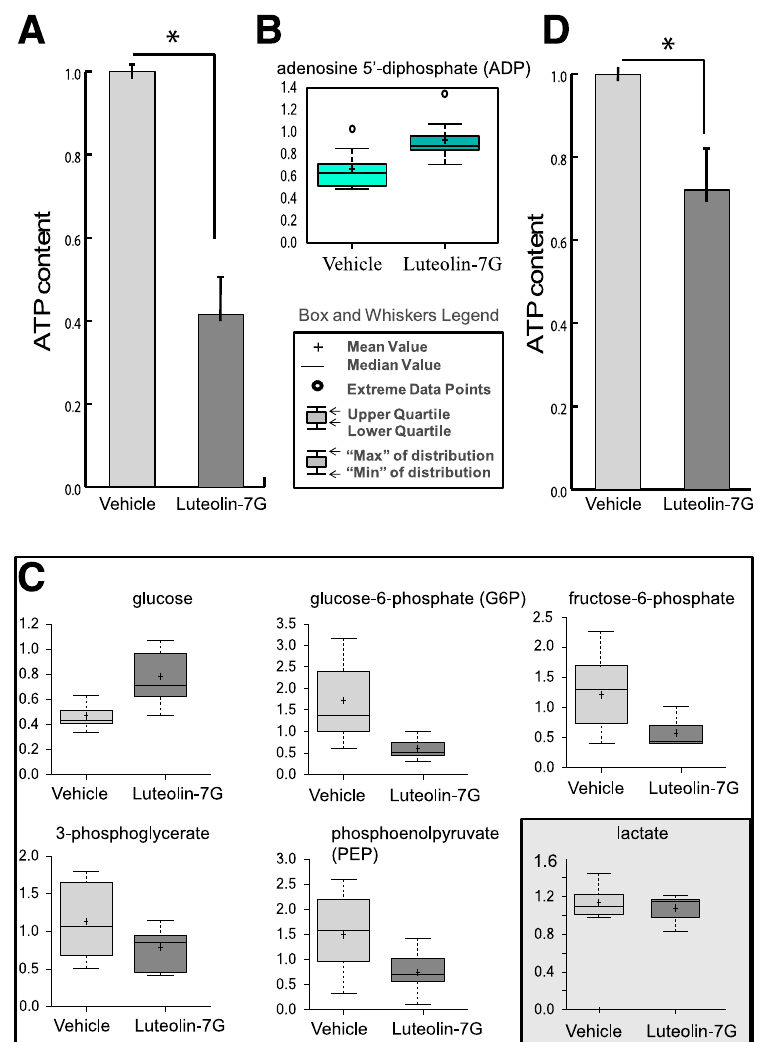
Figure 1. ( A ) Cellular ATP content in keratinocyte treated with LUT-7G showing a reduction of about 60%. ( B ) ADP content. ( C ) Metabolic analysis showing the decrease of G6P, F6P, and 3PG, as well of phosphoenolpyruvate (PEP). The cellular glucose (first upper panel) remains high inside cells. The data are represented as a boxplot from nine replicate samples. ( D ) ATP content of HaCaT cells (immortalized keratinocytes) showing a reduction of about 25% of ATP after LUT-7G treatment. * p < 0.05.